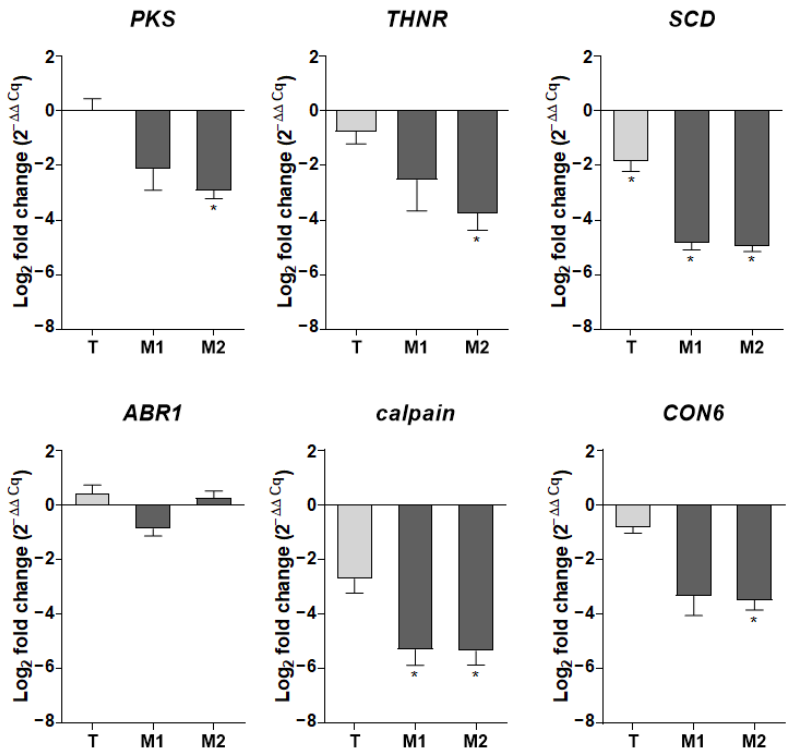
Figure 10. Fold-induction mRNA values for a selected panel of genes in the T, M1, and M2 strains relative to their parental ∆ KU70 strain. Expression levels of target genes were normalized against the expression of the S. apiospermum UBC6 and FIS1 housekeeping genes. Results are expressed as 2 − ∆∆ Cq , referring to the fold induction in the T, M1, and M2 strains relative to the mean quantification cycle obtained with the parental strains. Data are from four biological replicates: * p ≤ 0.05 (Mann- Whitney test). T: transformant derived from the WT strain; M1 and M2: transformants derived from the Δ KU70 strain.